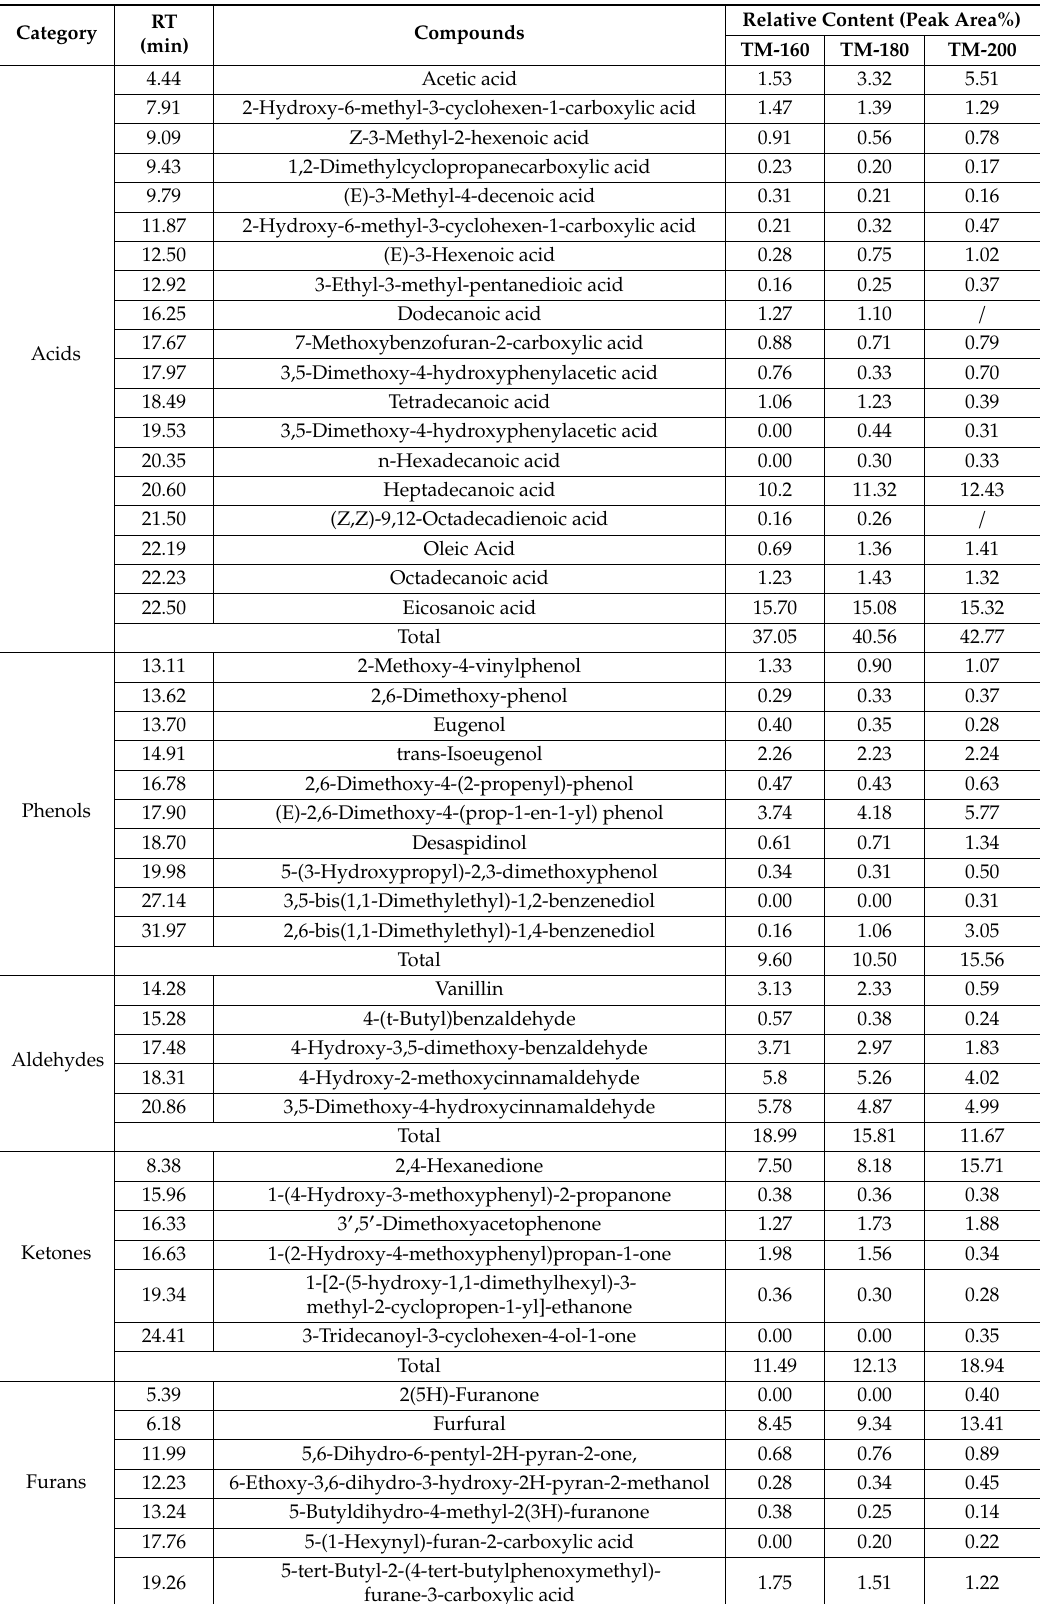
Table 2. Compounds and their relative contents in VOCs released from wood thermal modification at di ff erent